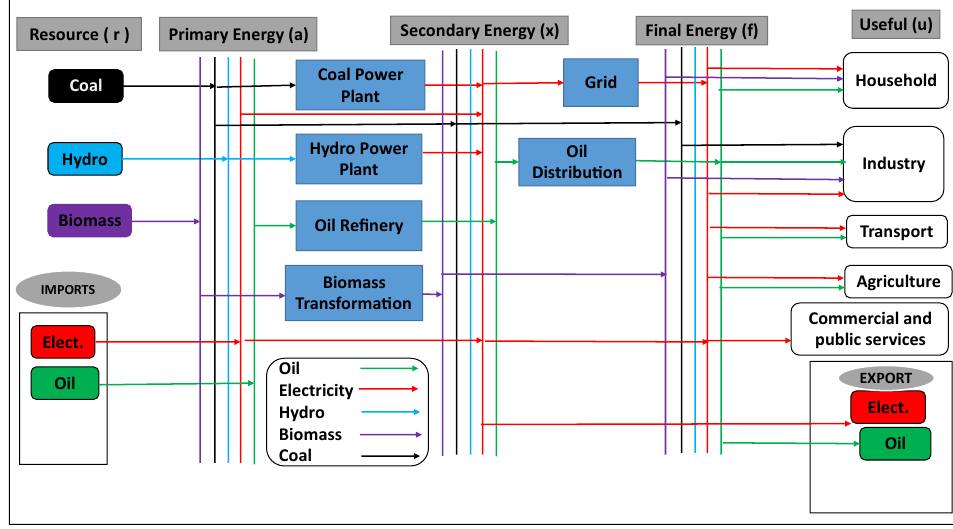
Figure 5. Reference energy system (RES) for Zambia.